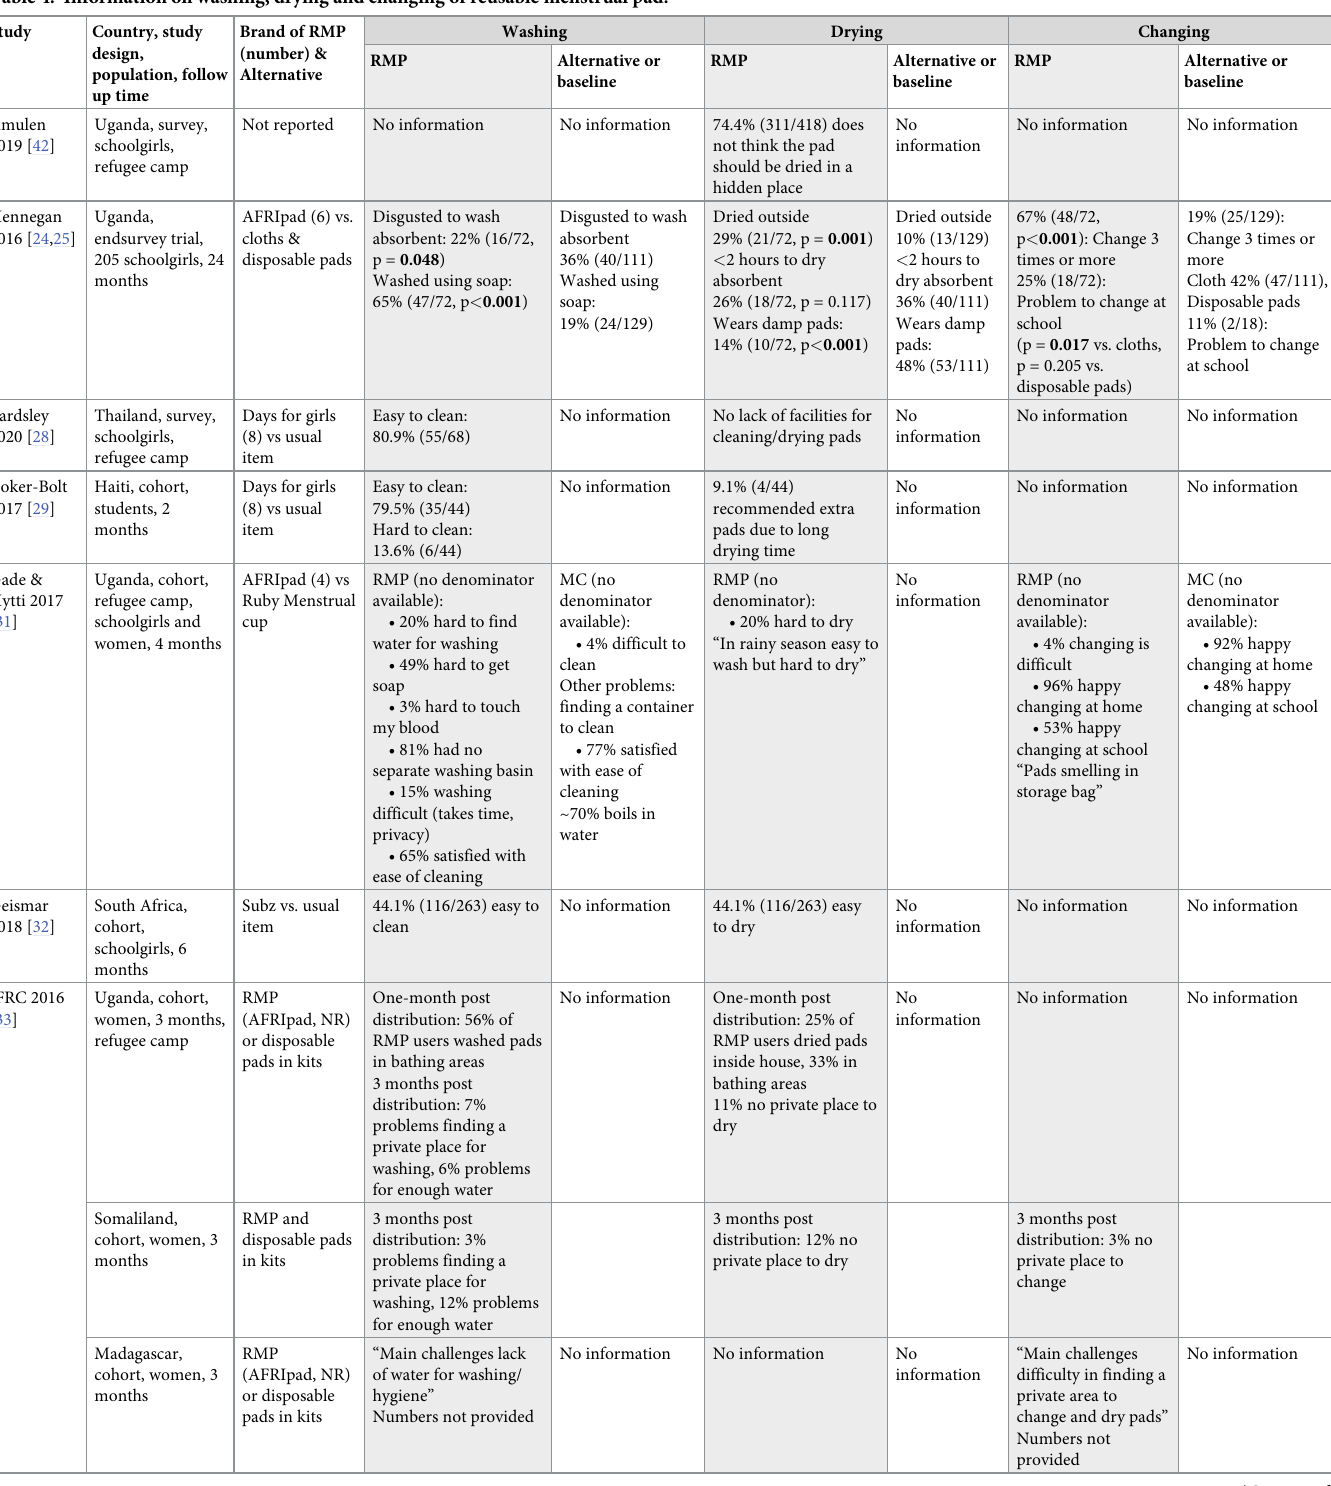
Table 4. Information on washing, drying and changing of reusable menstrual